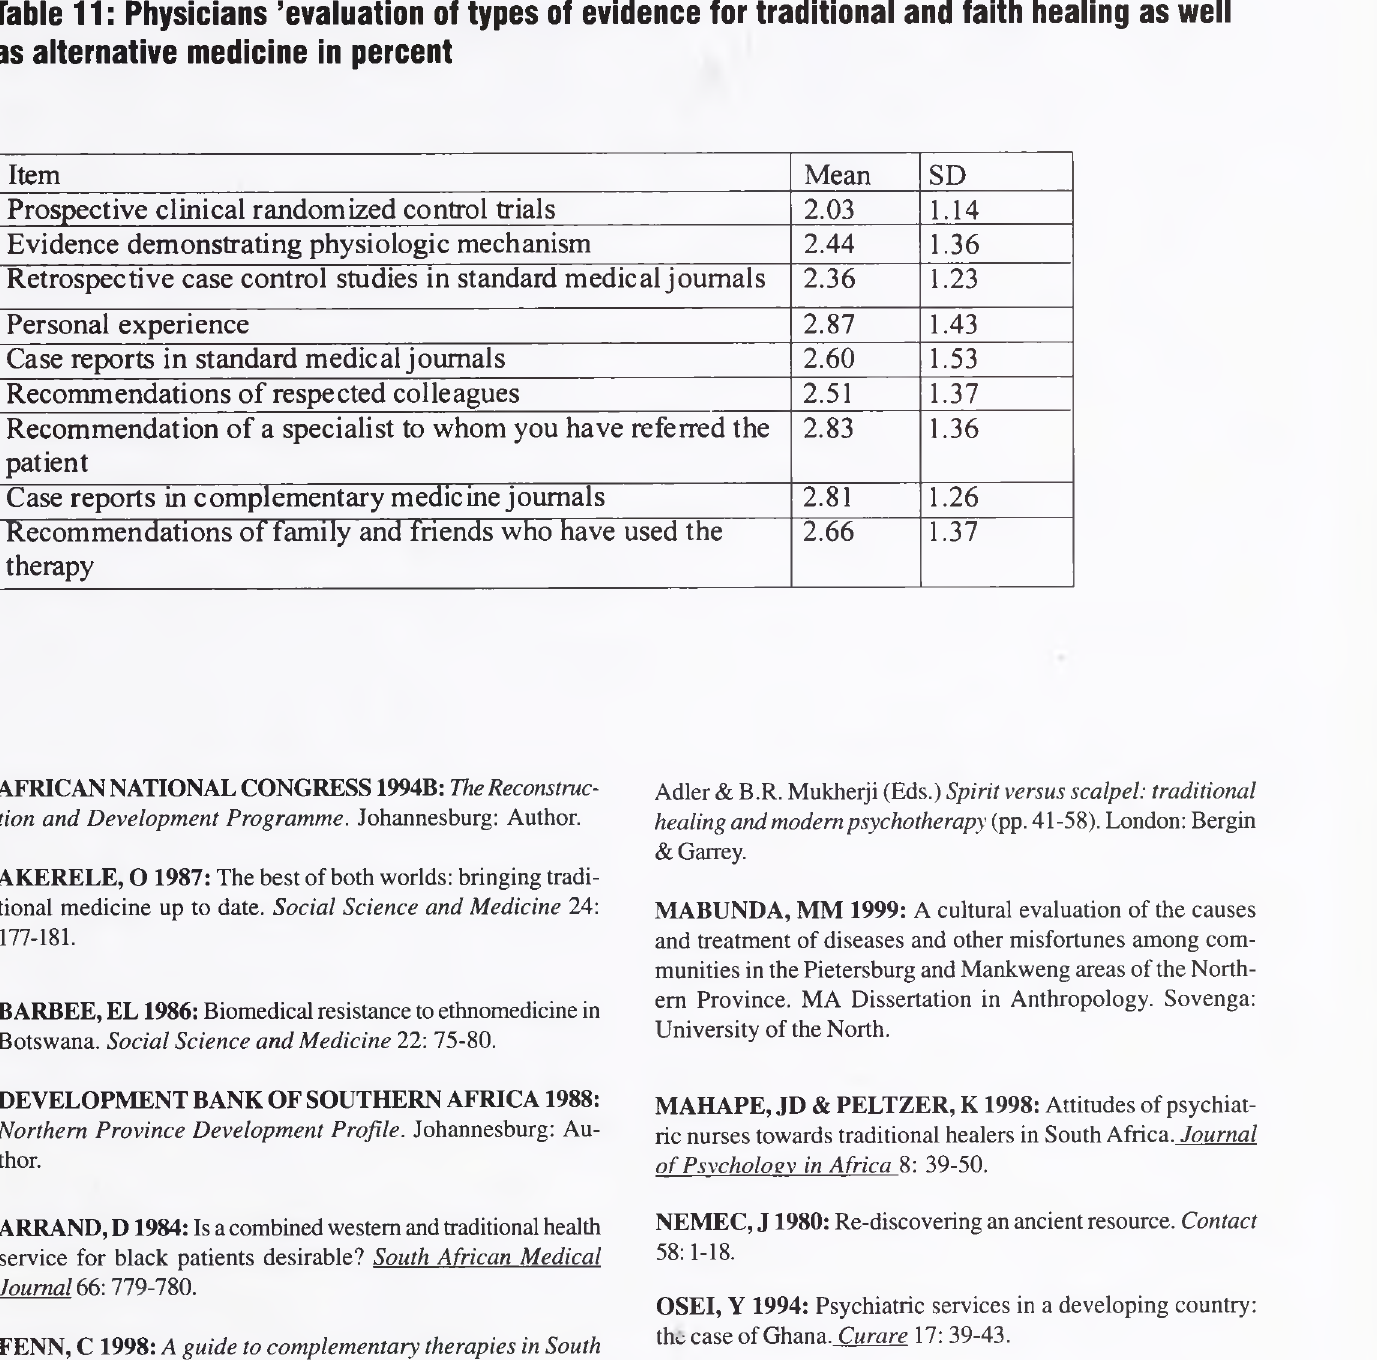
Table 11: Physicians ’evaluation of types of evidence for traditional and faith healing as well as alternative medicine in